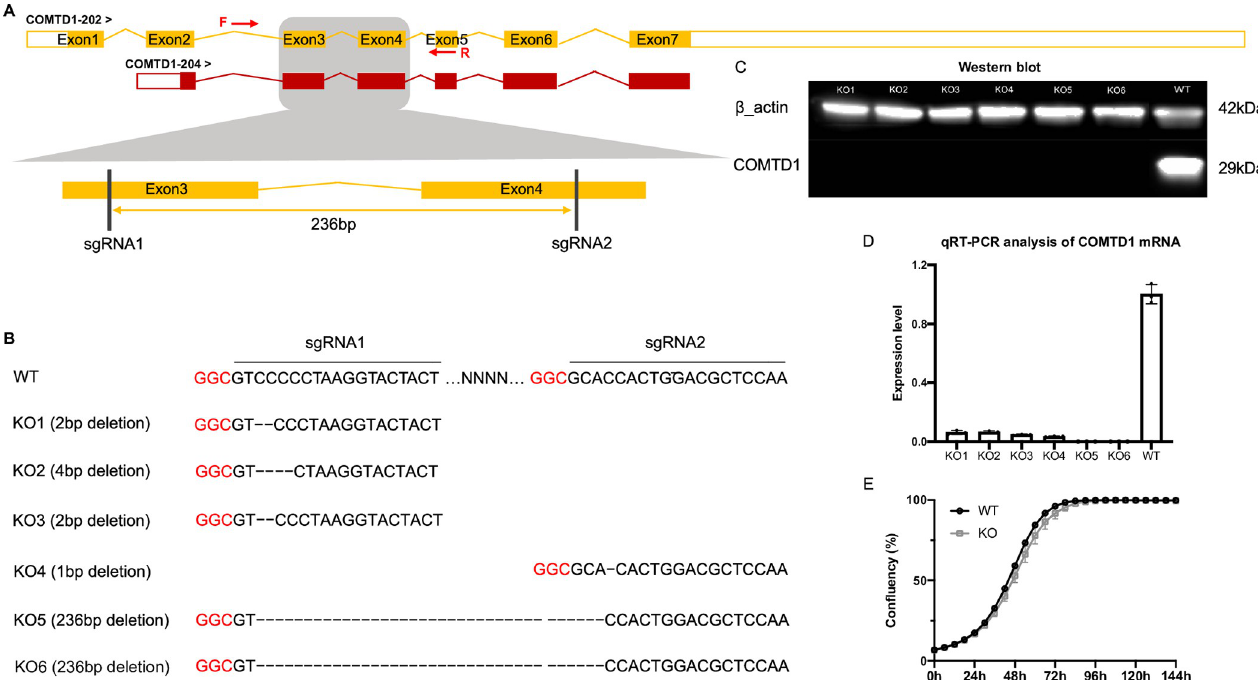
Fig 6. CRISPR/Cas9 mediated inactivation of Comtd1 in B16F10 cells. (A) Schematic description of CRISPR/Cas9 mediated inactivation of murine Comtd1 . Black bars indicate the target sites of two gRNAs in the exons of Comtd1 . Yellow arrow indicates a 236bp deletion introduced by paired sgRNAs. The primer pair indicated by red arrows is used for amplifying genomic DNA. (B) Six colonies retrieved from Comtd1 knockout in B16F10 cells. The PAM sequence is in red. Dash (-) indicates deleted nucleotides. The top one is wild type and the others are KO clones, of which, three lines (KO1, KO2, KO3) were generated using sgRNA1, one line was generated using sgRNA2, and the last two lines carrying 236bp deletion were generated by the sgRNA pair. (C) Western blot analysis of whole-cell lysates prepared from six COMTD1 knockout clones and one WT cell line using antibodies against COMTD1 and the control β -actin. (D) Quantitative RT-PCR analysis of Comtd1 expression in KO and WT cell lines. Date are presented as mean ± SD (n = 3 biological replicates). (E) Cell growth curves of KO (grey) and WT (black) were recorded by the Incucyte Zoom live-cell imaging system and data are expressed as cell confluence (%; mean ± SEM, n = 6 in KO, n = 3 in